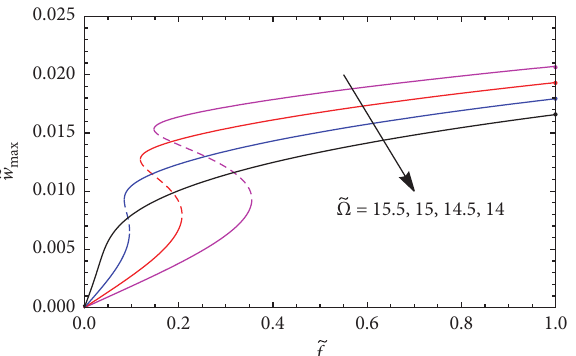
Figure 8: Effect of excitation frequency 􏽥 Ω on the force-response curves of the transverse vibration of SS BDFG porous beam when � m � 1, α � 0 . 1, L / h � 20, and 􏽥 c m x z 0